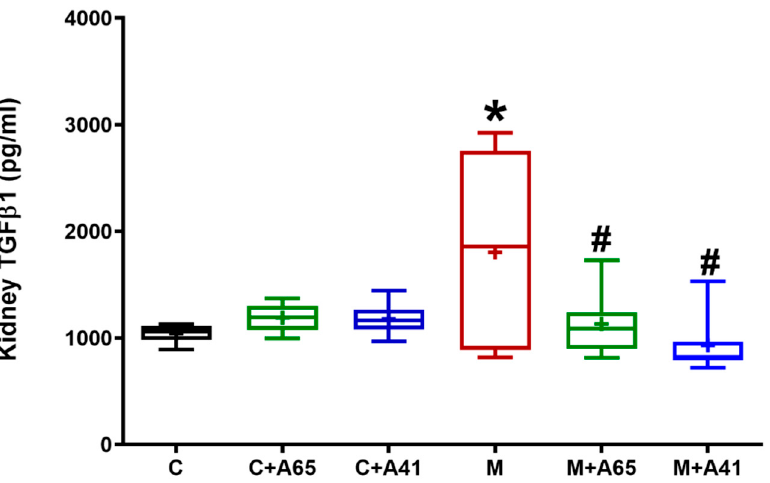
Figure 5. The CB1 receptor antagonists AM6545 and AM4113 reduce TGF β 1 production in fructose- induced metabolic syndrome rats. The concentration of TGF β 1 was measured in the control (C) and metabolic syndrome (M) rats as well as control and metabolic rats treated with AM6545 (C + A65) and (M + A65), respectively, or AM4113 (C + A41) and (M + A41), respectively, at a dose of 10 mg/kg/day. Results are shown as box plots and the mean is shown as (+) ( n = 8). * p < 0.05 relative to the control group and # p < 0.05 relative to the metabolic syndrome group by one-way ANOVA followed by Tukey’s post hoc test. Table 3. The effects of AM6545 and AM113 on correlation between albumin excretion rate (AER) and kidney level of the transforming growth factor beta 1 (TGF β